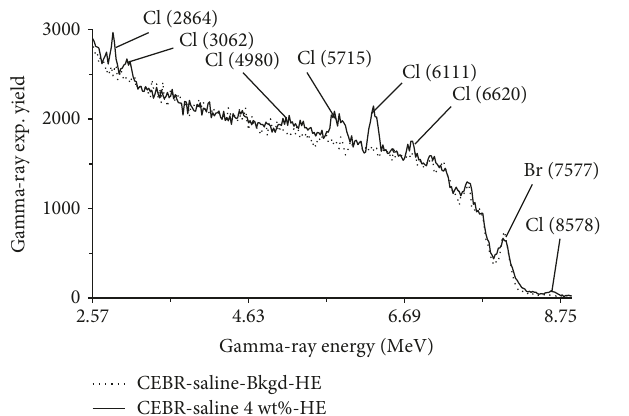
Figure 9: Enlarged high-energy pulse height spectrum of the CeBr detector for a saline water sample over 2.57 – 8.75MeV range from a 4% chlorine-contaminated water sample superimposed upon background spectrum.